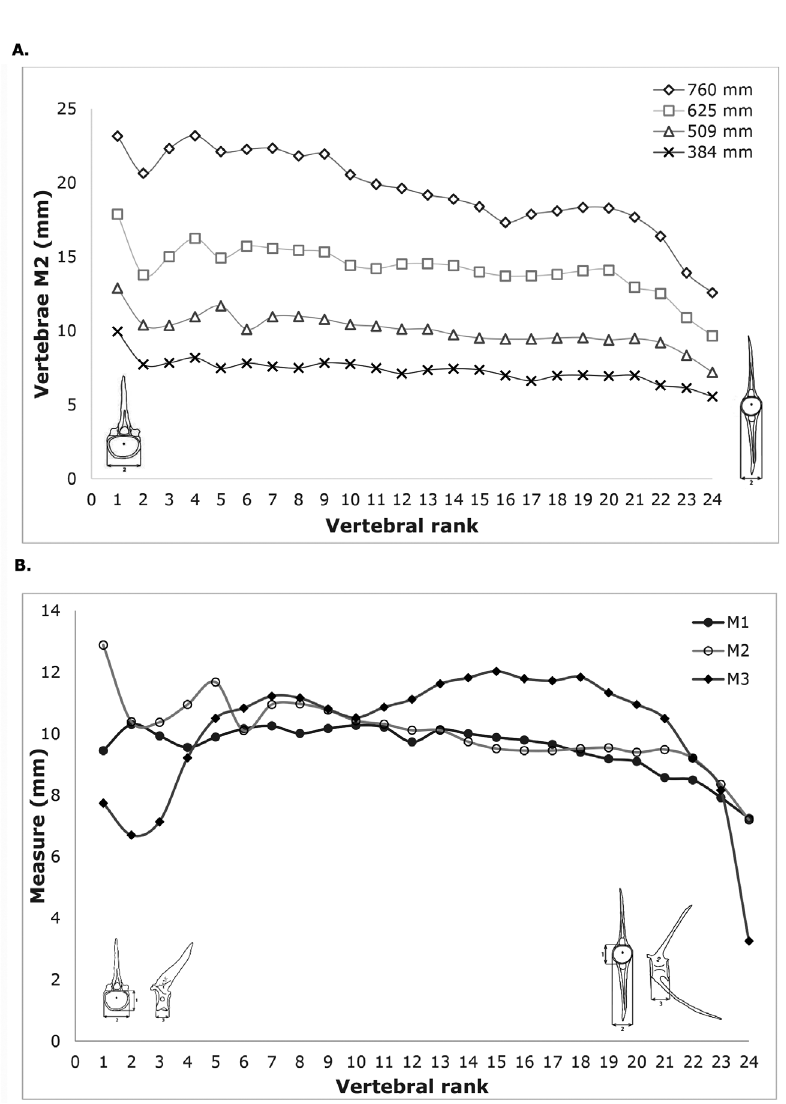
FIGURE 5 | Global Rachidian Profiles of Lutjanus argentiventris . A. Measurement 2 of four Lutjanus argentiventris individuals (TL = 384 mm; TL = 509 mm; TL = 625 mm; TL = 760 mm). B. Measurements 1, 2 and 3 of one Lutjanus argentiventris individual (TL = 509